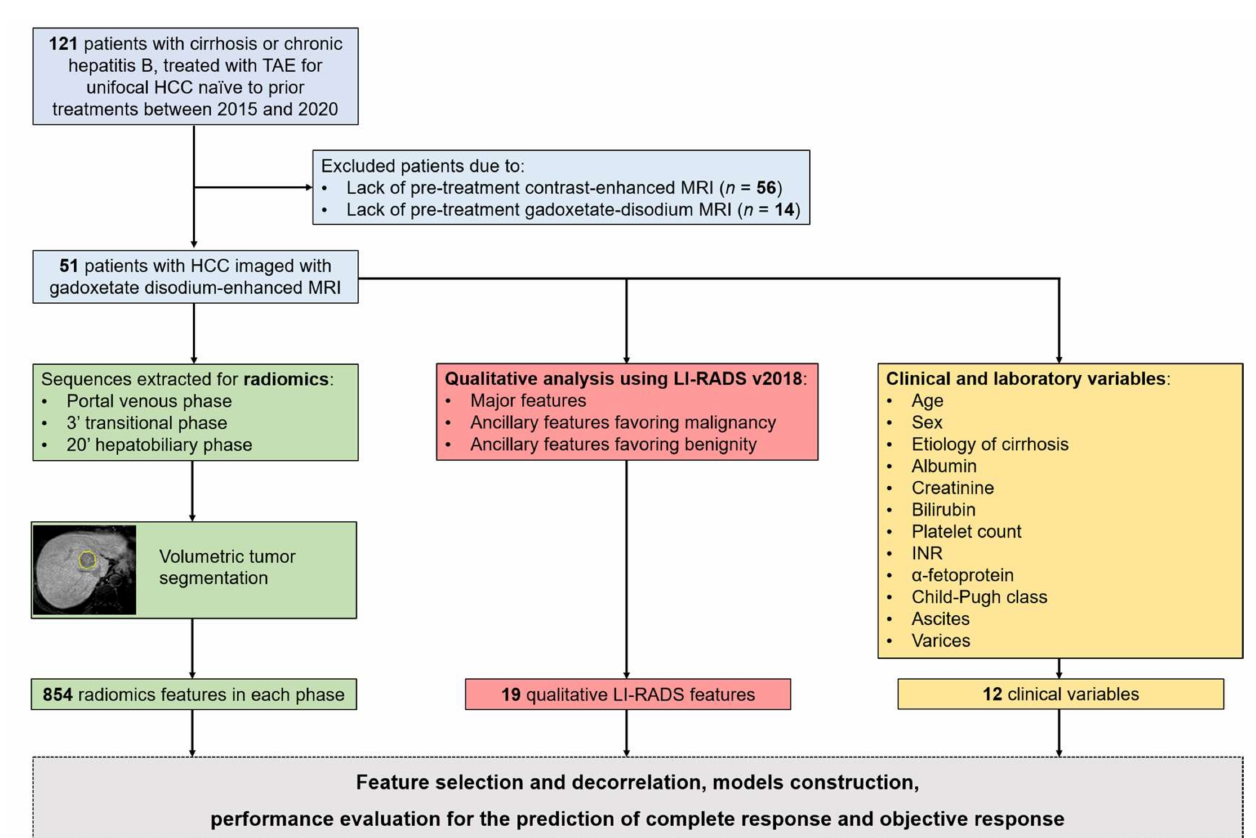
Figure 1. Flowchart of patients’ accrual for the study. Abbreviations: HCC: Hepatocellular Carci- noma; LI-RADS: Liver Imaging Reporting and Data System; MRI: Magnetic Resonance Imaging; TAE: Transarterial